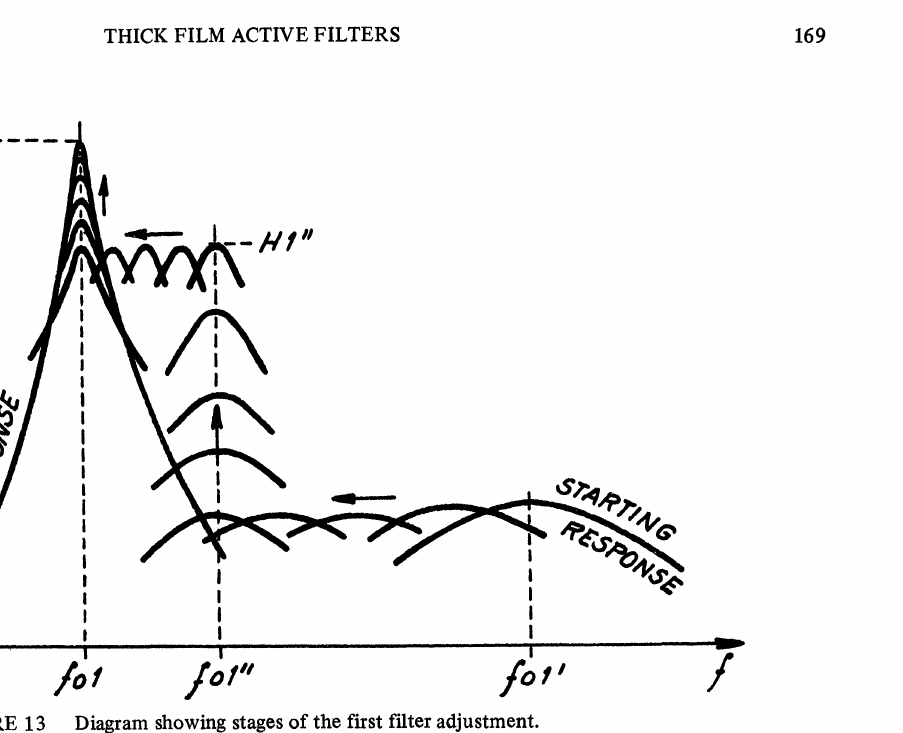
FIGURE 13 Diagram showing stages of the first filter